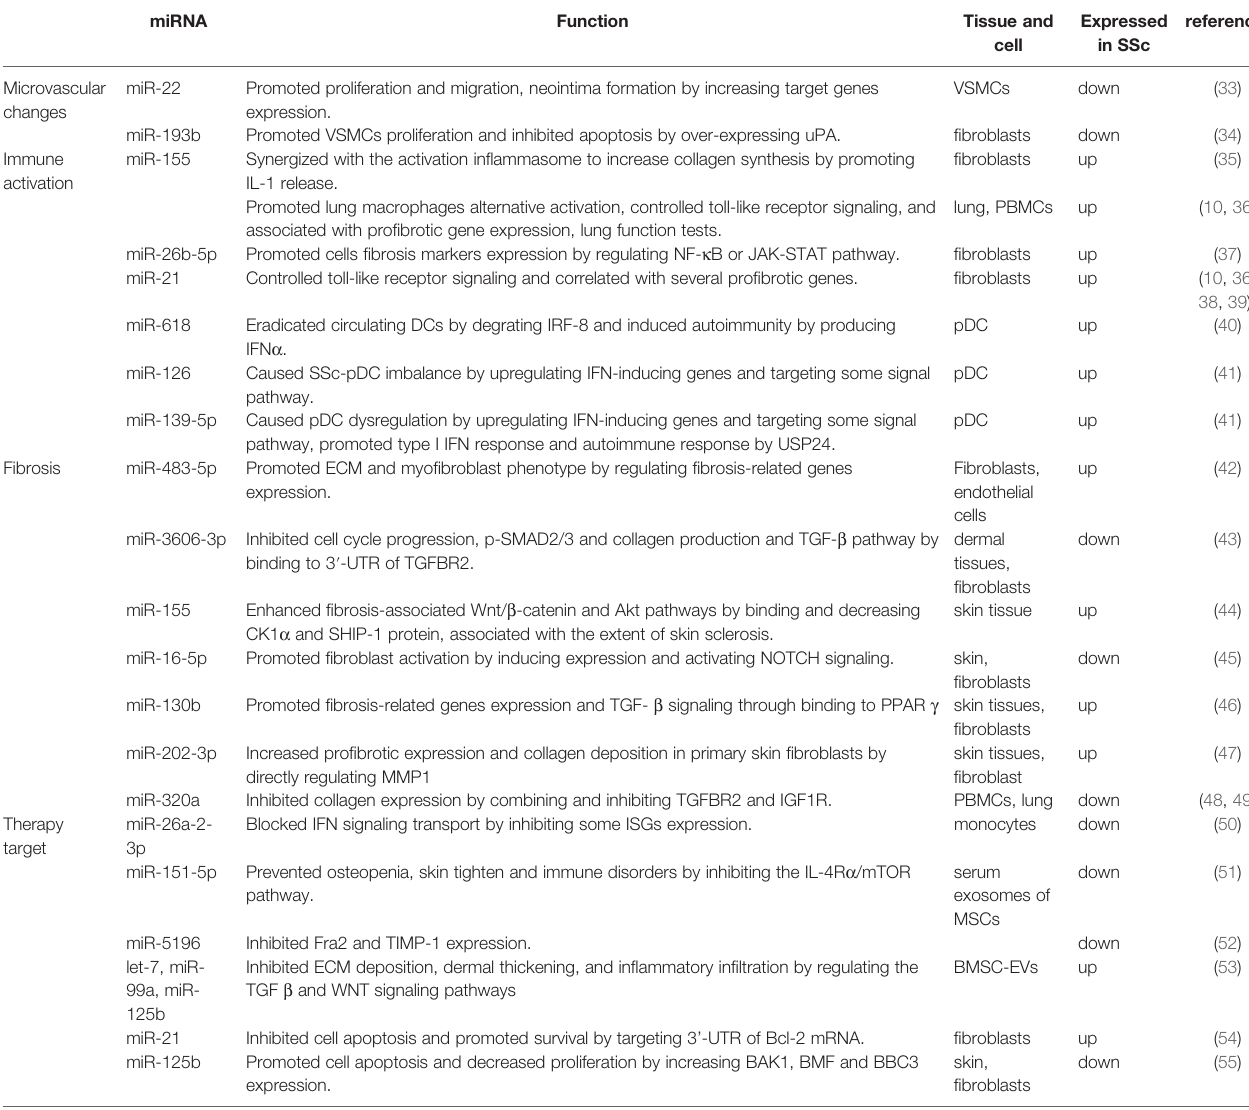
TABLE 1 | The Role of miRNAs in SSc. miRNA Function Tissue and